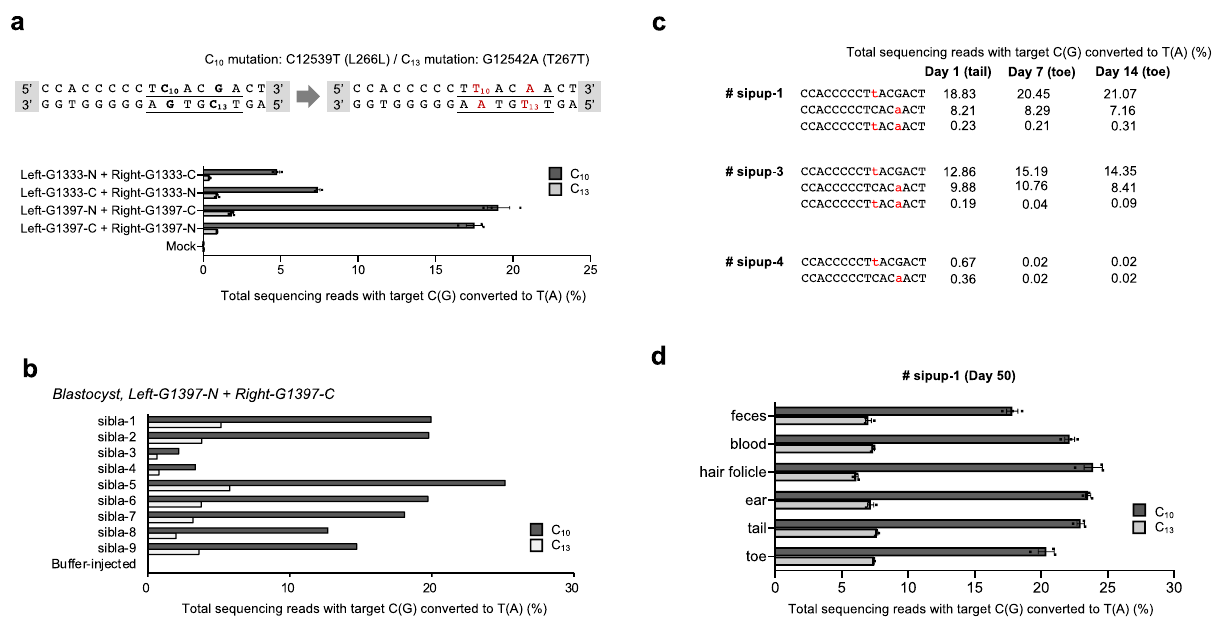
Fig. 2 Mouse mitochondrial ND5 point mutation generated by DdCBE-derived base editing. a DdCBE deaminase-mediated cytosine-to-thymine base editing target and ef fi ciency in NIH3T3 cells. In the target sequence, translation codons are underlined and possible editing loci are shown in red. Transfected combinations of DdCBE are annotated as left or right, -G1333 or -G1397, and -N or -C. P values of left-G1333-N + right-G1333-C, left-G1333-C + right-G1333-N, left-G1397-N + right-G1397-C, and left-G1397-C + right-G1397-N for C 10 mutation are 0.0012, 0.0003, 0.0014, and 0.0009, and for C13 mutation are 0.0116, 0.0076, 0.0030, and 0.0003, respectively ( * p <0.05 and ** p <0.01 using Student ’ s two-tailed t test). b Corresponding base editing ef fi ciency in mouse blastocysts. The sequencing data were obtained from blastocysts that developed after zygotes were microinjected with mRNA encoding the left-G1397-N and right-G1397-C DdCBE. c Alignments of mutant sequences from newborn pups. Targeted deep sequencing was performed using genomic DNA isolated from the tail of the newborns immediately after birth, and that from the toe 7 and 14 days after birth. Edited bases are shown in red. Editing frequencies in the mutant mitochondrial genome are shown. d Editing ef fi ciencies in various tissues of an adult F 0 mouse (sipup-1). The sequencing data were obtained from each tissue 50 days after birth. In all graphs, the dark and light gray bars represent the frequency of m.C12539T (C 10 ) and m.G12542A (C 13 ) mutations, respectively. Error bars are the standard error of the mean (s.e.m.) for n = 3 biologically independent samples. Source data are provided in the Source data fi le.